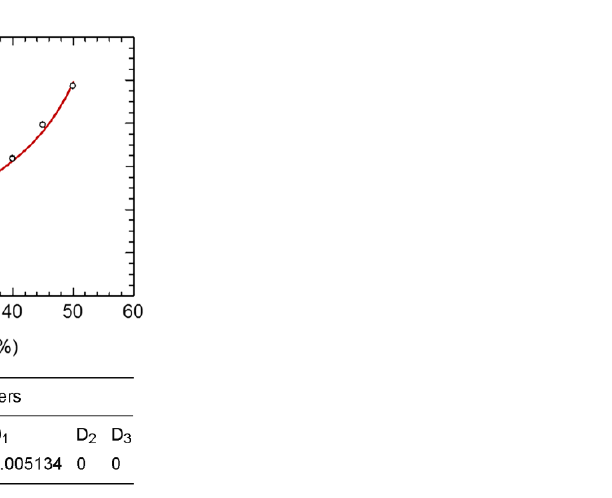
Figure 7. Maximum compressive stress response vs. the peak strain and hyperelastic parameters of disc-A during a hyperelastic period of the stress relaxation test.